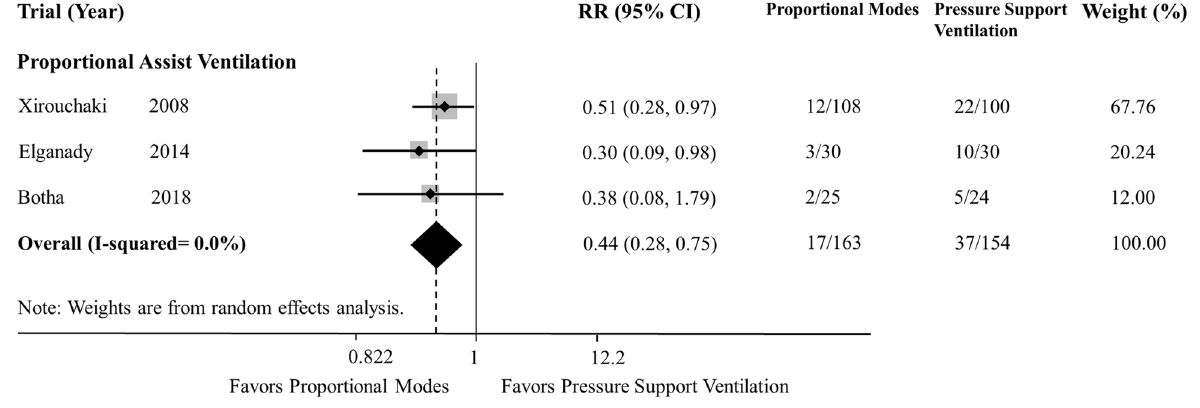
Fig. 3 Relative risk of weaning failure in included studies. RR risk ratio